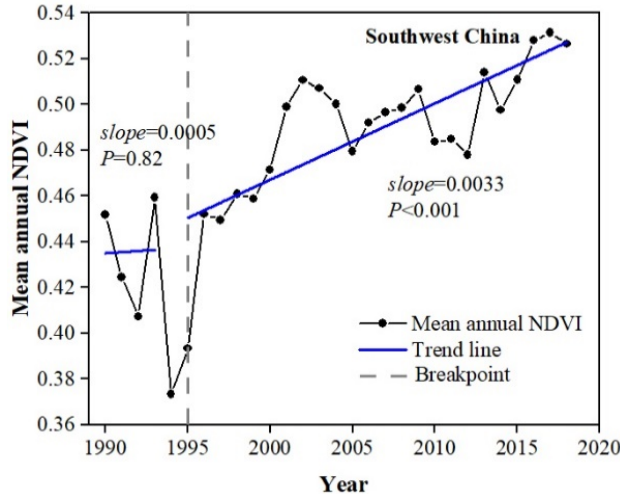
Figure 7. Abrupt change in trends based on BFAST algorithm in NDVI from 1990 to 2018.